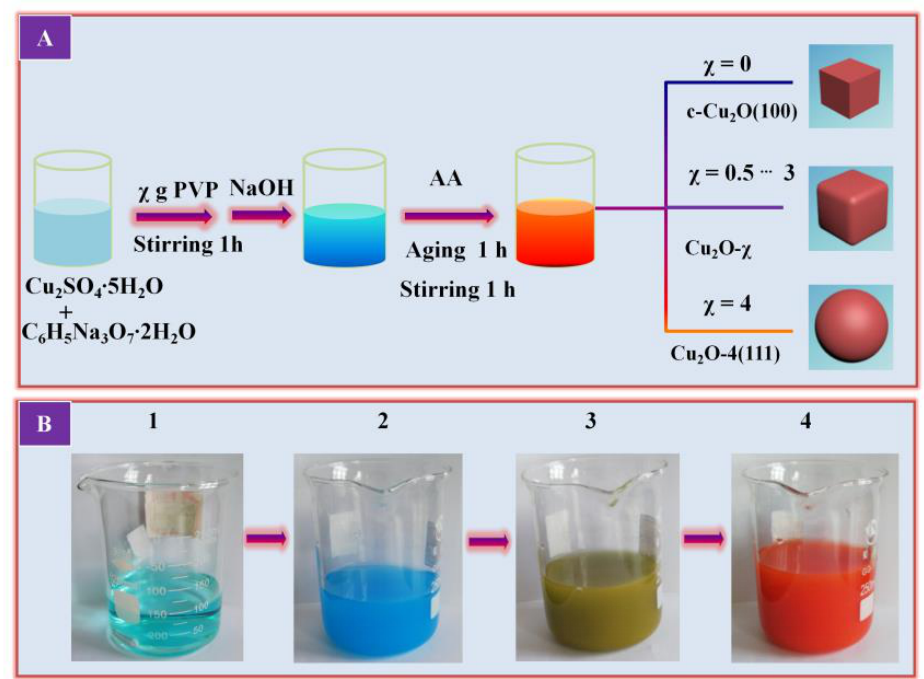
Scheme 1. ( A ) Schematic illustration for the preparation of Cu 2 O growth process, ( B ) the color change of solution during preparation progress of Cu 2 O nanocrystals. In Figure ( A ), χ